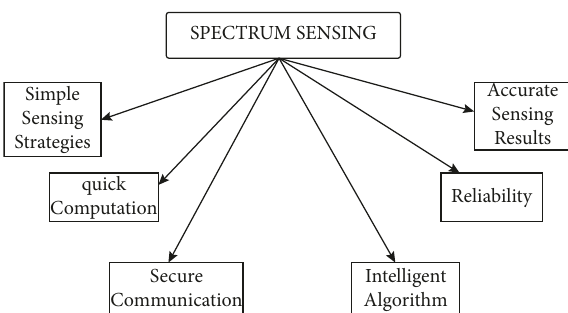
Figure 9: Requirements for spectrum